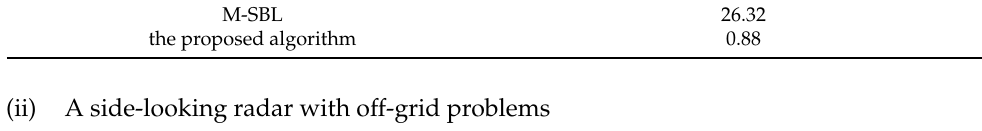
Table 4. Running time of different algorithms for a side-looking radar with off-grid problems.